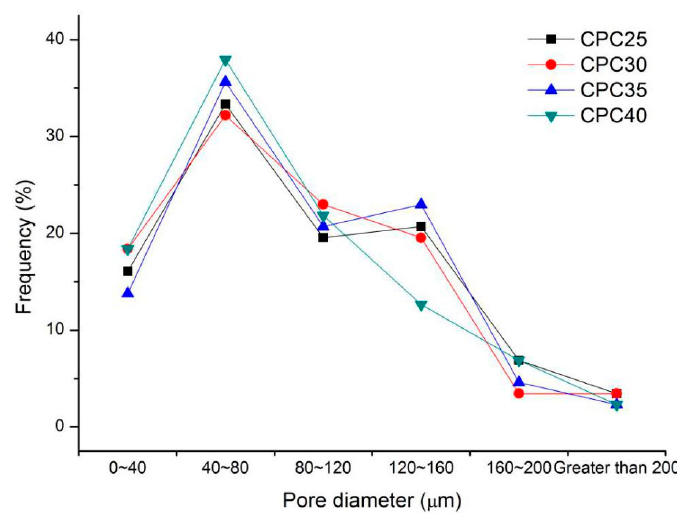
Figure 14. Pore size distribution of the air-void structure of series III mixtures.